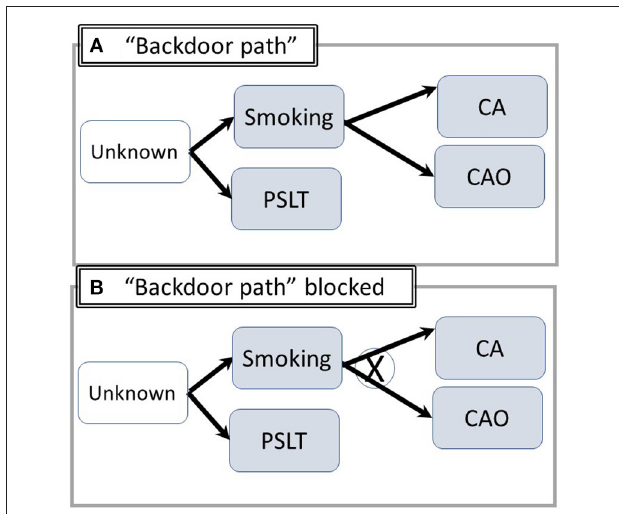
FIGURE 2 | Utilizing DAG’s to illustrate “Backdoor Paths” /confounding. (A) (“Backdoor Path”): Common unknown/unspecified factors increase the likelihood of both smoking and exposure. An artifactual apparent association between PSLT and CA/CAO may appear. X = pathway blocked by proper adjustment. (B) Adjustment for smoking blocks the pathway including PSLT-Unknown-CA (Abbreviations are summarized in Figure 1